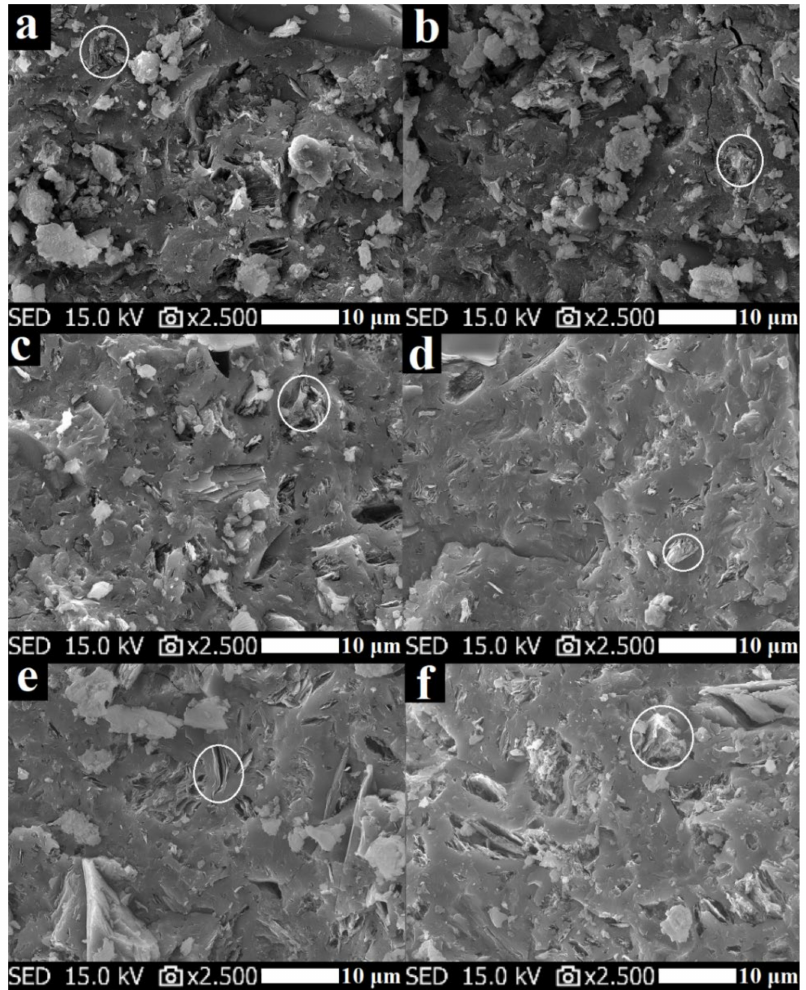
Figure 11. Micrographs of geopolymer binders with various molar ratios of K/Al (( a )—GB-0.55, ( b )—GB-0.70, ( c )—GB-0.85, ( d )—GB-1.0, ( e )—GB-1.15, ( f )—GB-1.30) at laboratory temperature. SEM images of geopolymer binders with different K/Al molar ratios after exposure